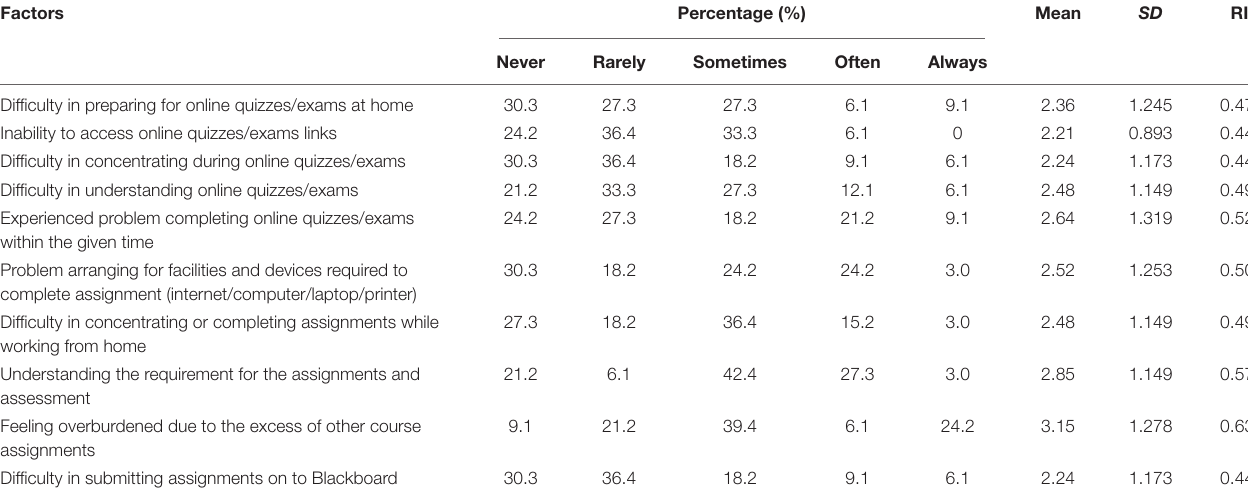
TABLE 3 | Students’ experiences with online assignments and assessments. Factors